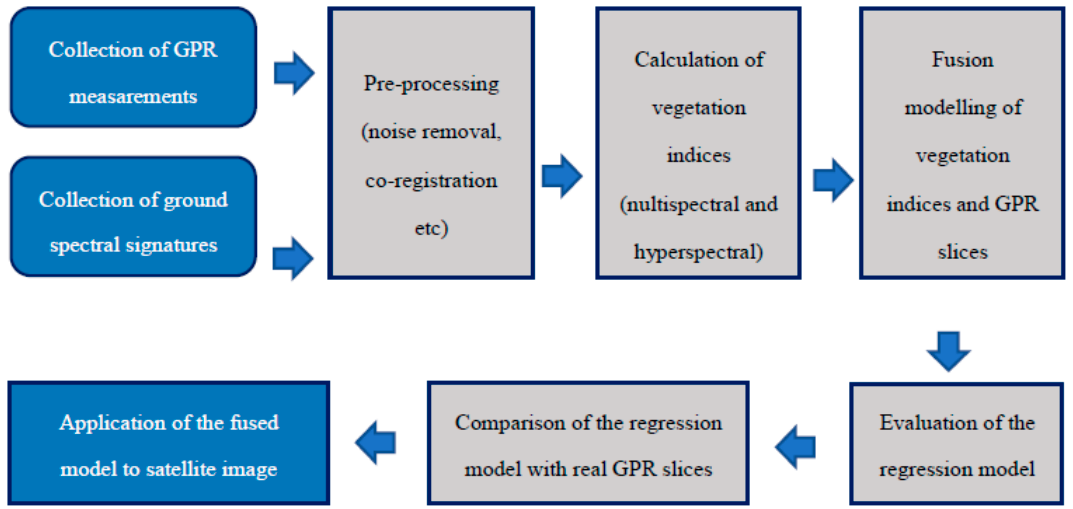
Figure 15. Overall methodology of the proposed work.